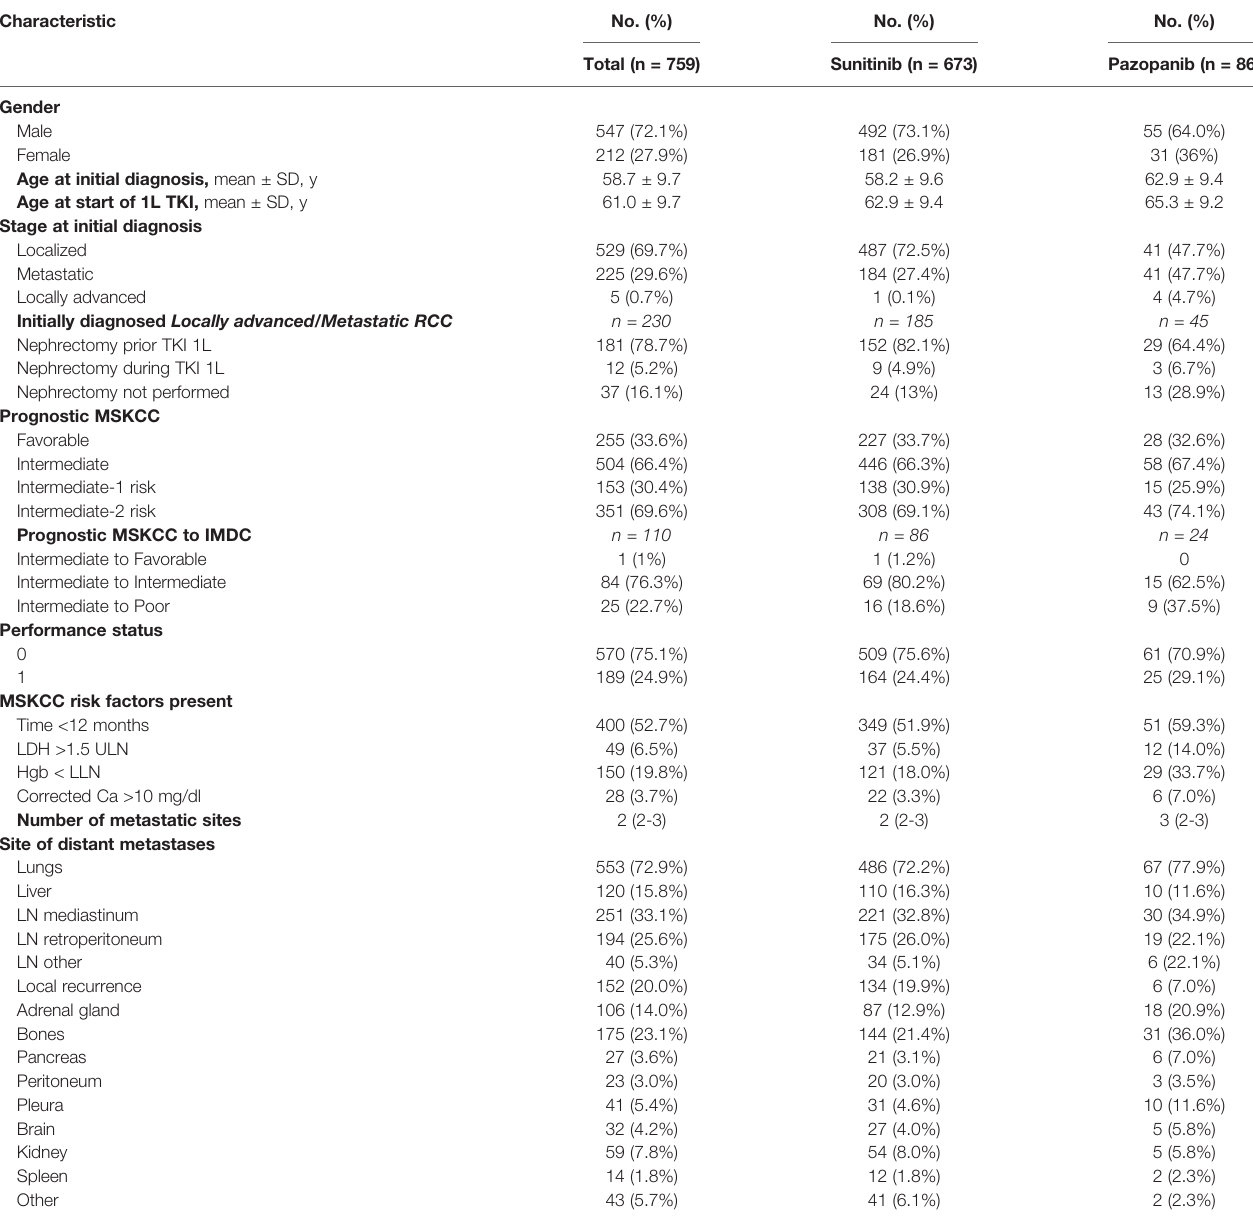
TABLE 1 | Demographic and clinical characteristics at baseline.